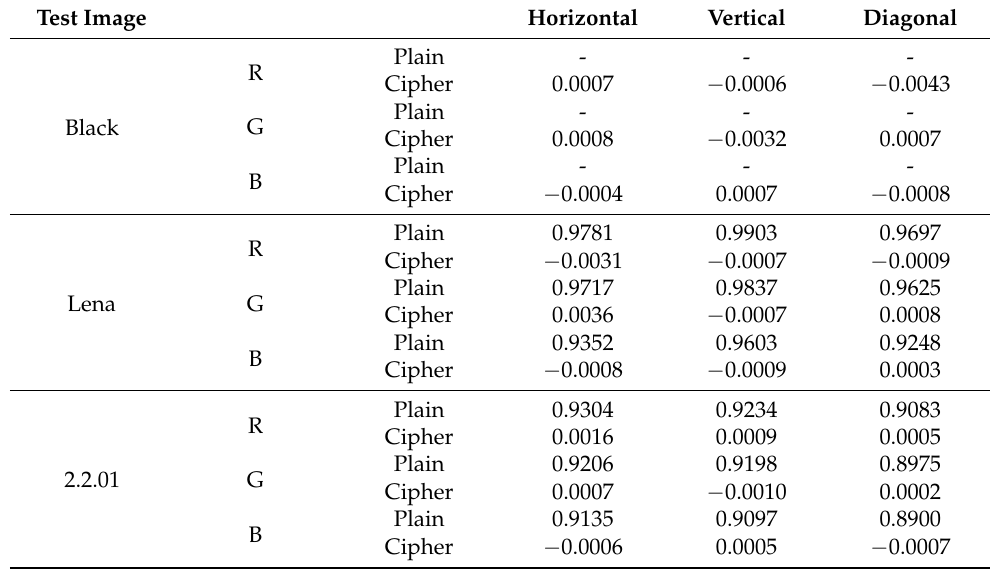
Table 3. Three-channel correlation comparison between experimental image and cipher